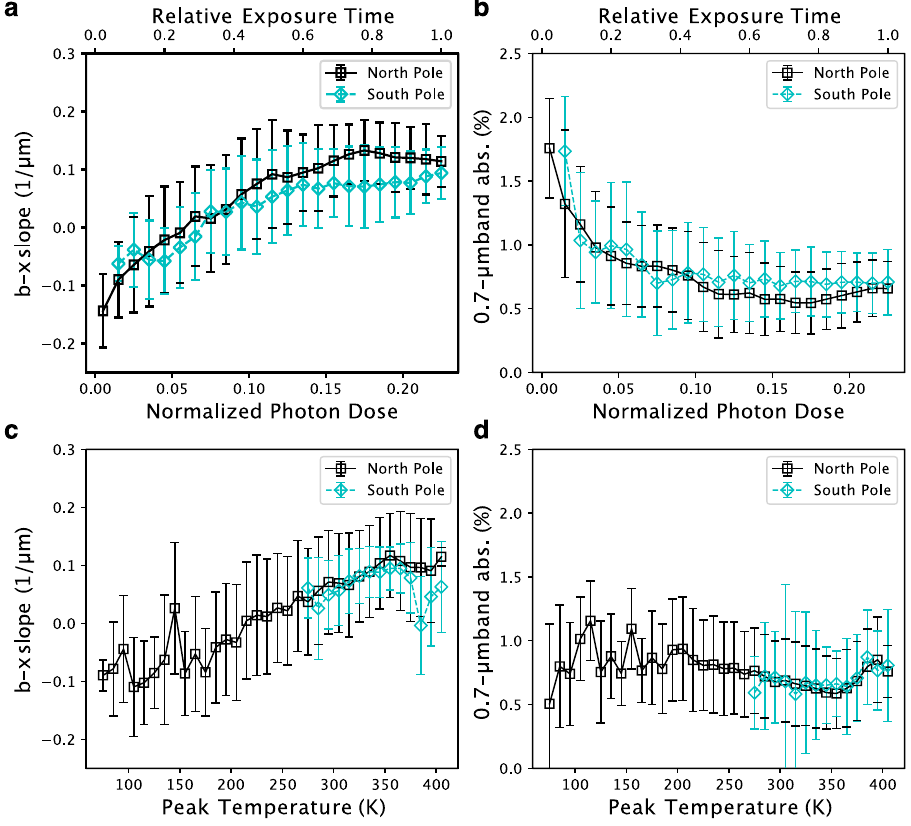
Fig. 6 Comparison between observed spectrophotometric indexes and modeled values. a b – x slope value versus normalized photon dose. b 0.7- µ m band absorption versus normalized photon dose. c b – x slope value versus peak temperature at perihelion. d 0.7- µ m band absorption versus peak temperature at perihelion. The north polar observation (Fig. 1a) and the south pole observation (Fig. 1c) are shown with black and cyan markers, respectively. Observed spectrophotometric indexes are binned by every 0.1 for photon dose and every 10 K for peak temperature. Error bars indicate the standard deviation in each bin. Relative exposure time for a , b is calculated such that the most irradiated surface is de fi ned as unity. Image ids used for this fi gure are listed in Supplementary Table